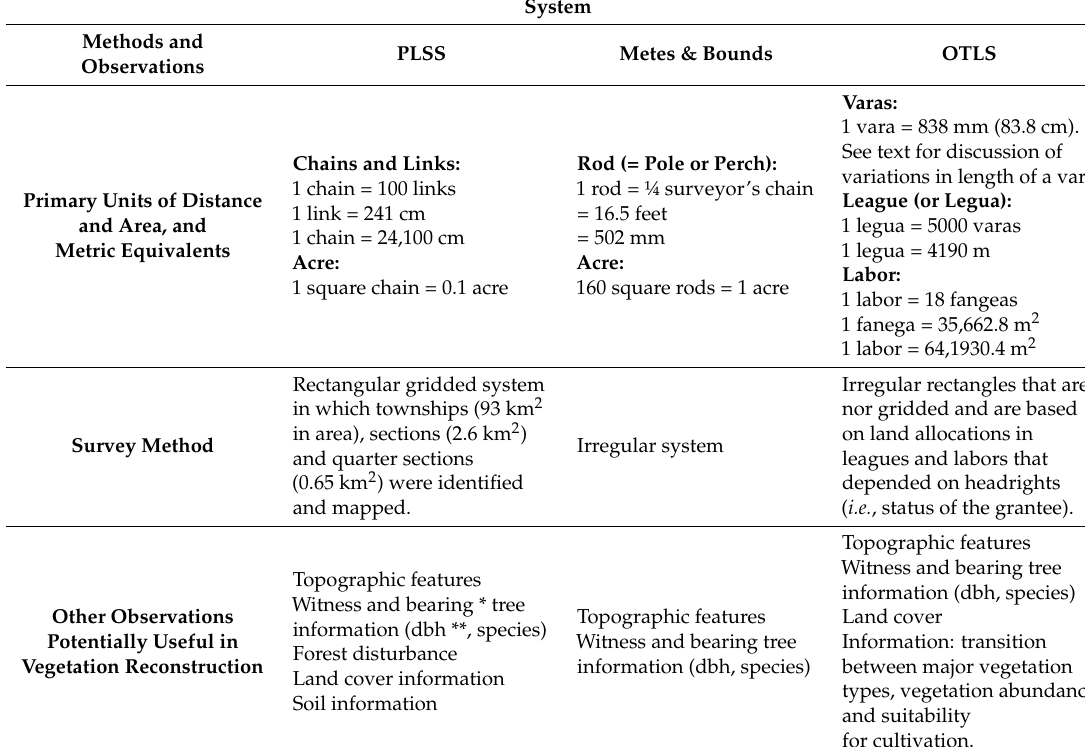
Table 1. A comparison of the key elements of the Public Land Survey System (PLSS), Metes and Bounds and Original Texas Land Survey (OTLS) survey systems in relation to vegetation